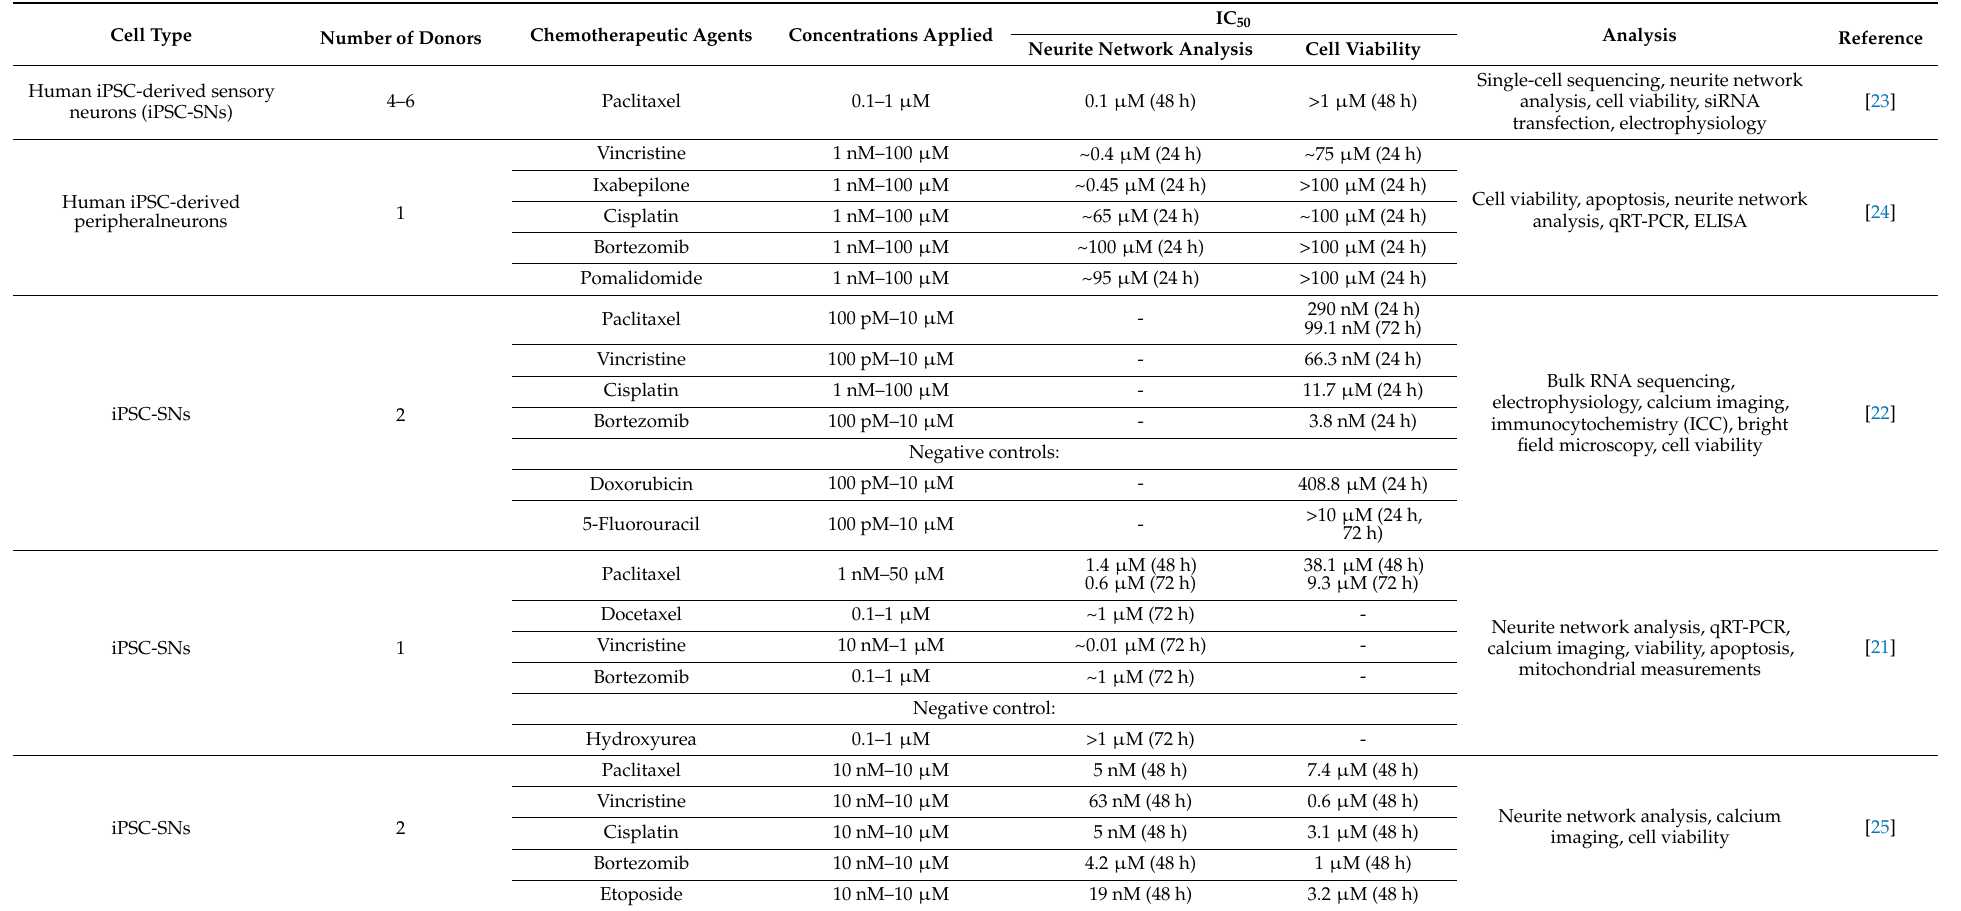
Table 1. Comparison of IC 50 values across different models of human induced pluripotent stem cell-derived neurons and across various chemotherapeutic agents and their applied concentrations and duration of chemotherapy